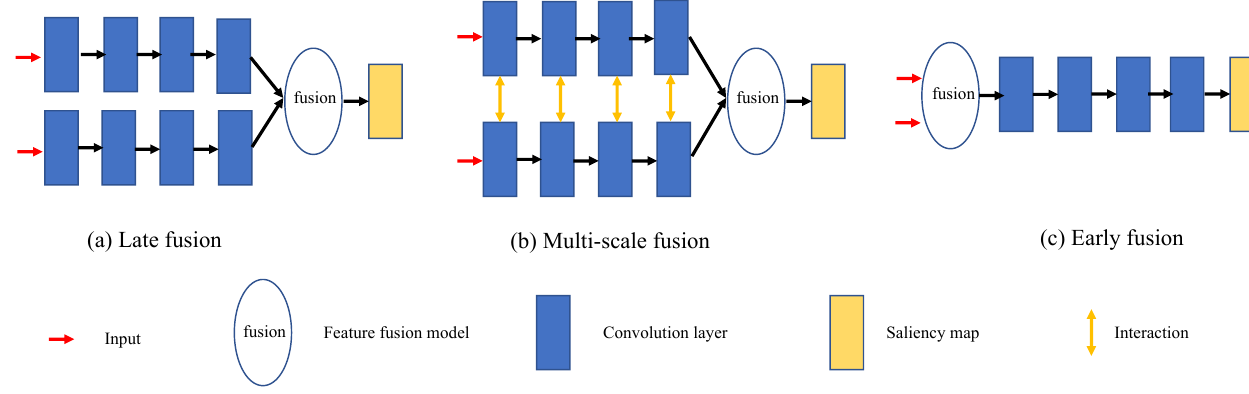
Figure 1. Comparison of three fusion